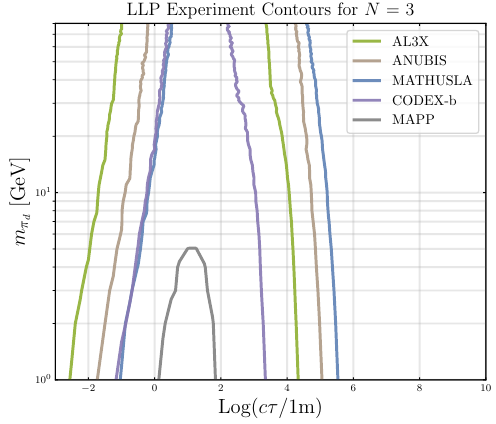
Figure 4 . Experimental sensitivity 95% confidence interval, assuming a completely background- free experiment. These contours assume a fixed mediator mass of M X